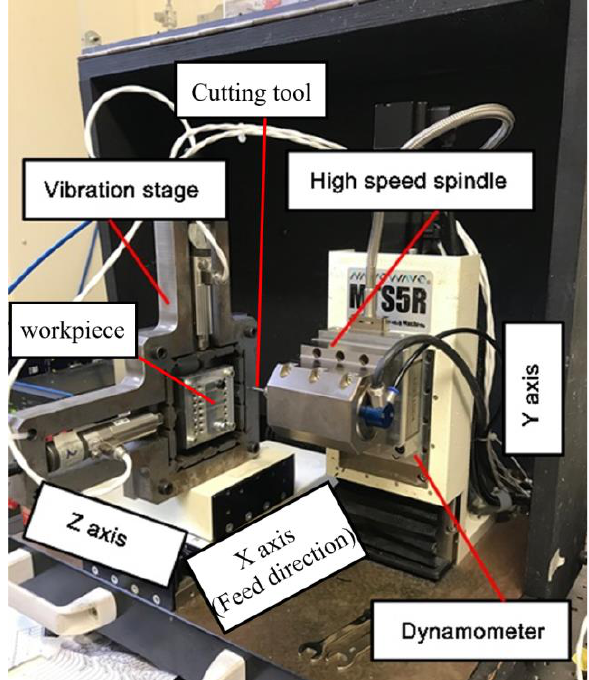
Figure 5. Layout of vibration-assisted micro milling equipment.